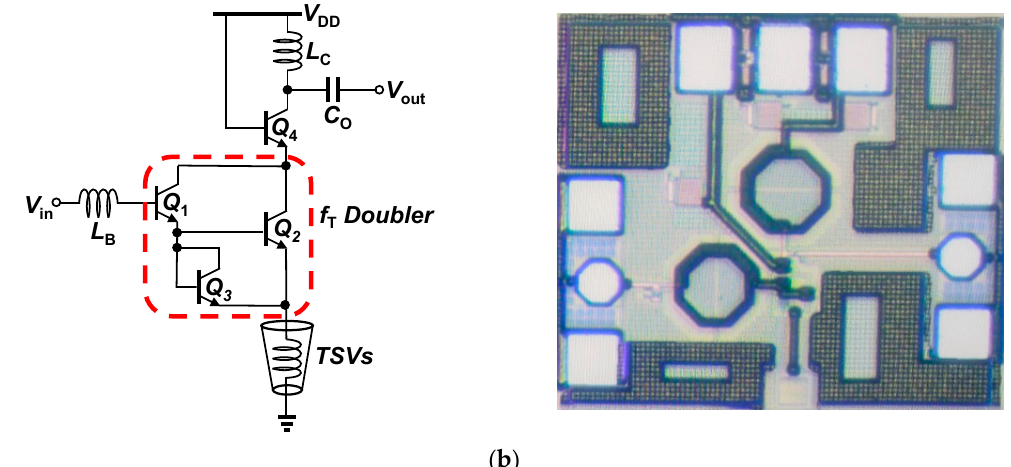
Figure 1. ( a ) Schematic and micrograph of the conventional through-silicon vias (TSV)-integrated unity-gain frequency ( f T )-doubler amplifier; ( b ) the schematic of the proposed TSV-integrated cascode Silicon-germanium (SiGe) heterojunction bipolar transistor (HBT) amplifier (biasing is not shown).